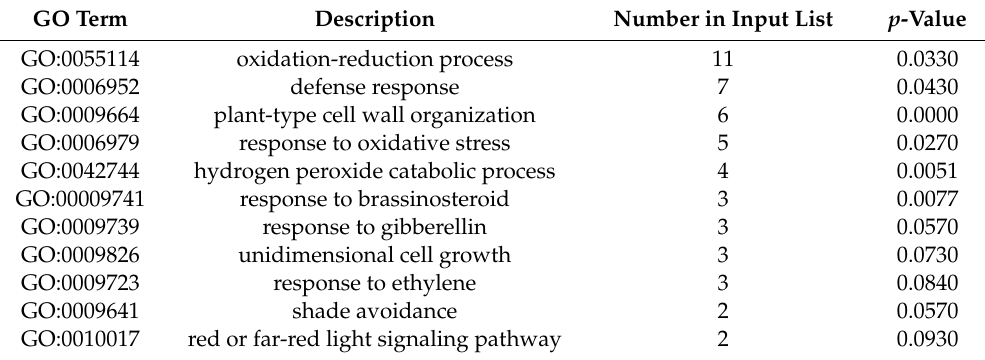
Table 3. Biological process categories of GO annotation of downregulated genes in AtRH17